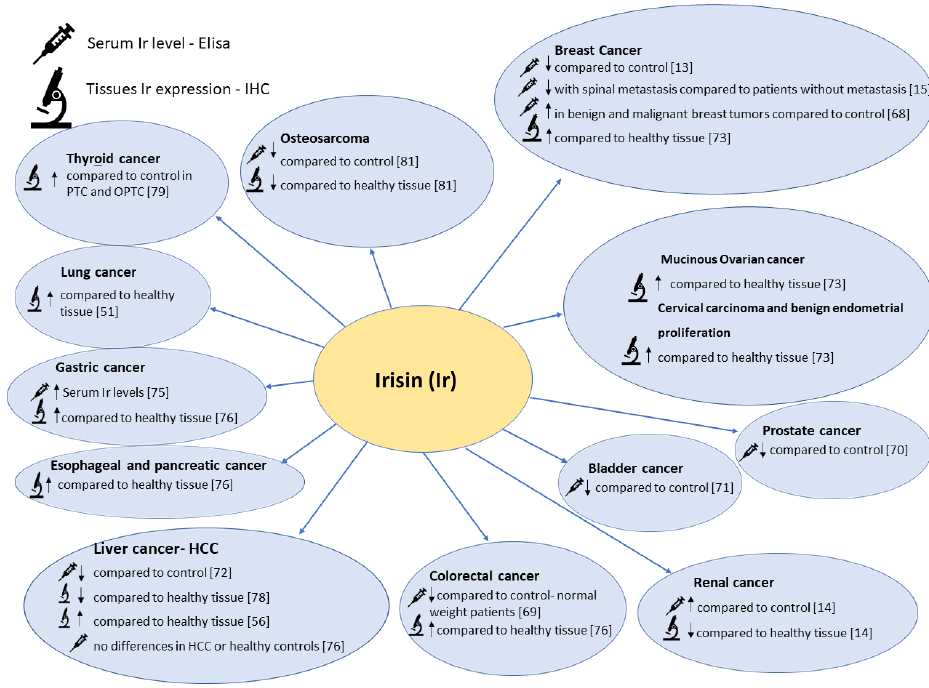
Figure 4. The figure shows the comparison between serum Irisin levels and IHC Irisin expression levels in different types of cancers.